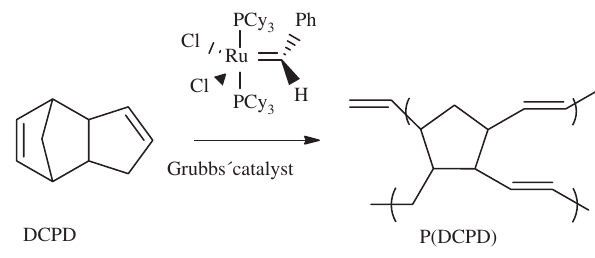
Scheme 1 Schematic representation of the ring-opening meta- thesis polymerization (ROMP) of trans -2-[3-(4- tert -butylphenyl)-2-